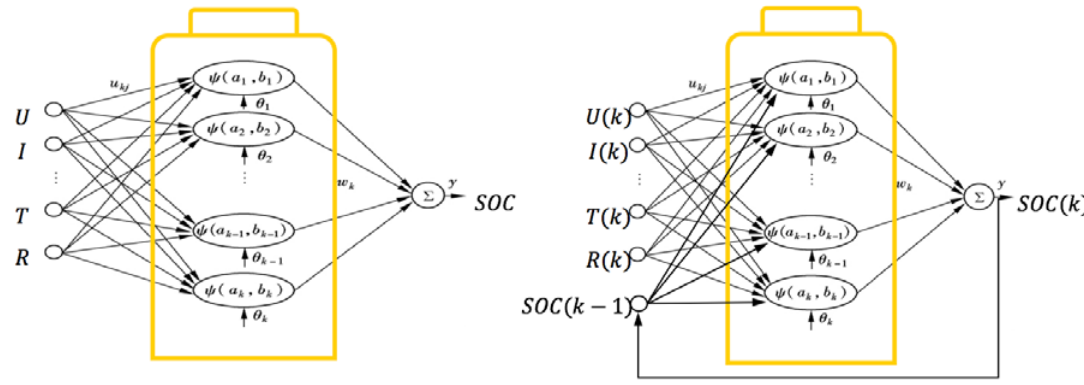
Figure 5. The complete structure of ANN for estimating SOC [109].